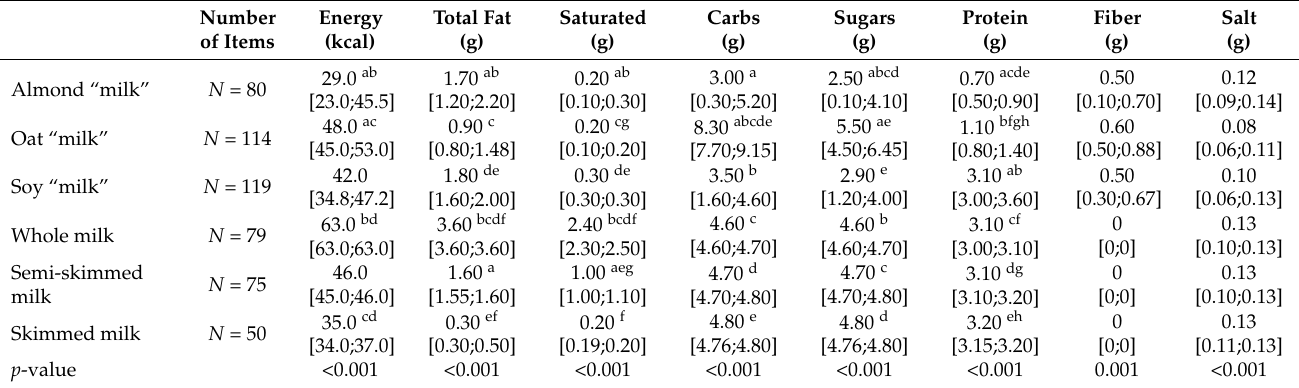
Table 1. Nutrient composition from the front-of-pack labelling by beverages, per 100 mL of AB milks and PB